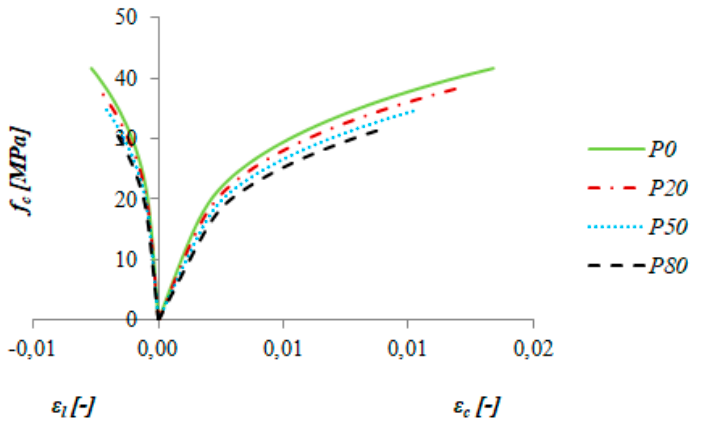
Figure 10. Theoretical pre-load effect.